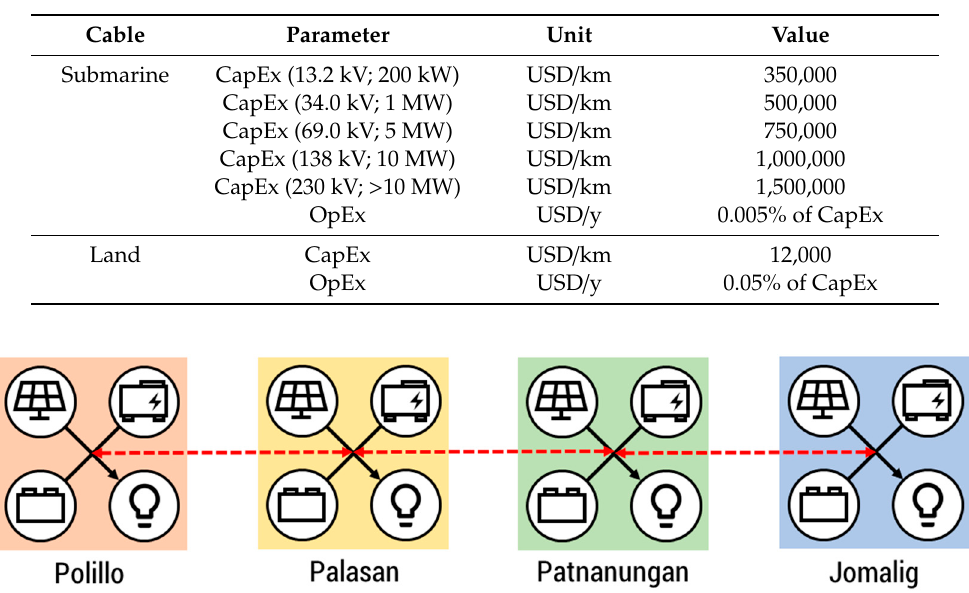
Table 4. Techno-economic parameters of interconnection cables [11].